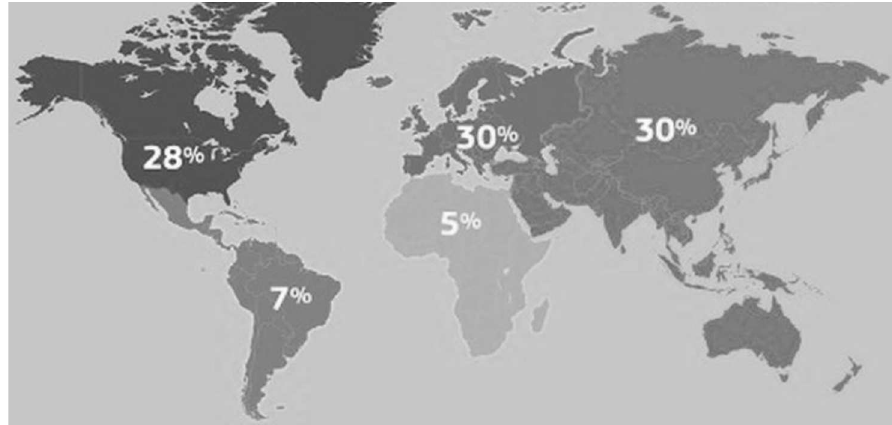
Figure 1. Percentage distribution of the mobile medical apps market value in 2017 (European Commission,